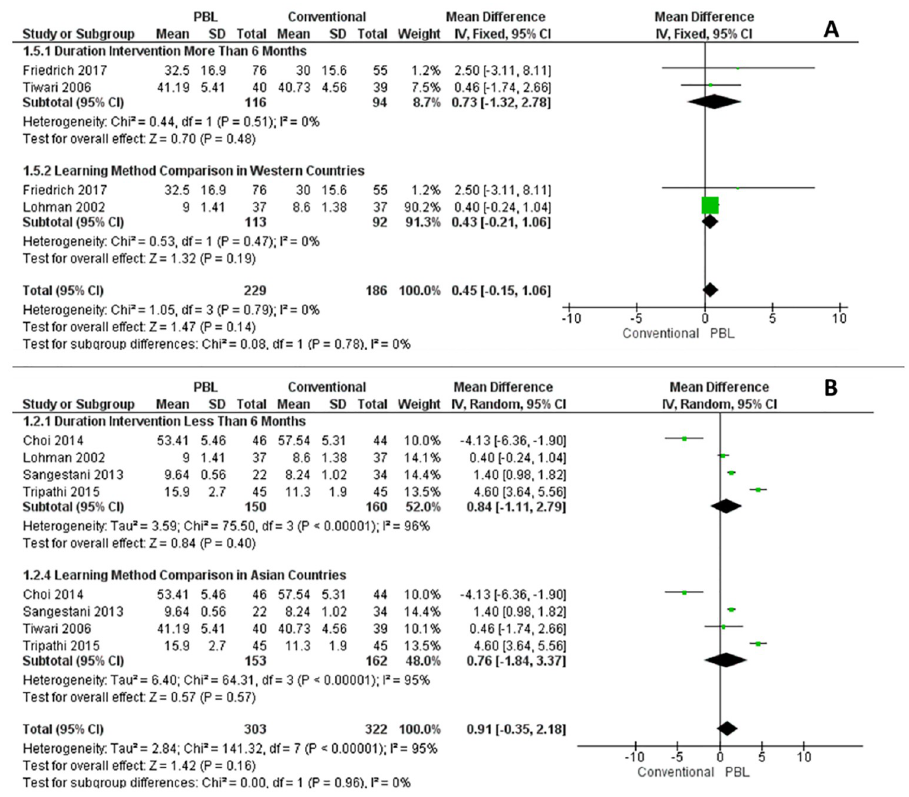
Fig 3. Subgroup analysis of critical thinking/knowledge. (A) Fixed effect models. (B) Random effect